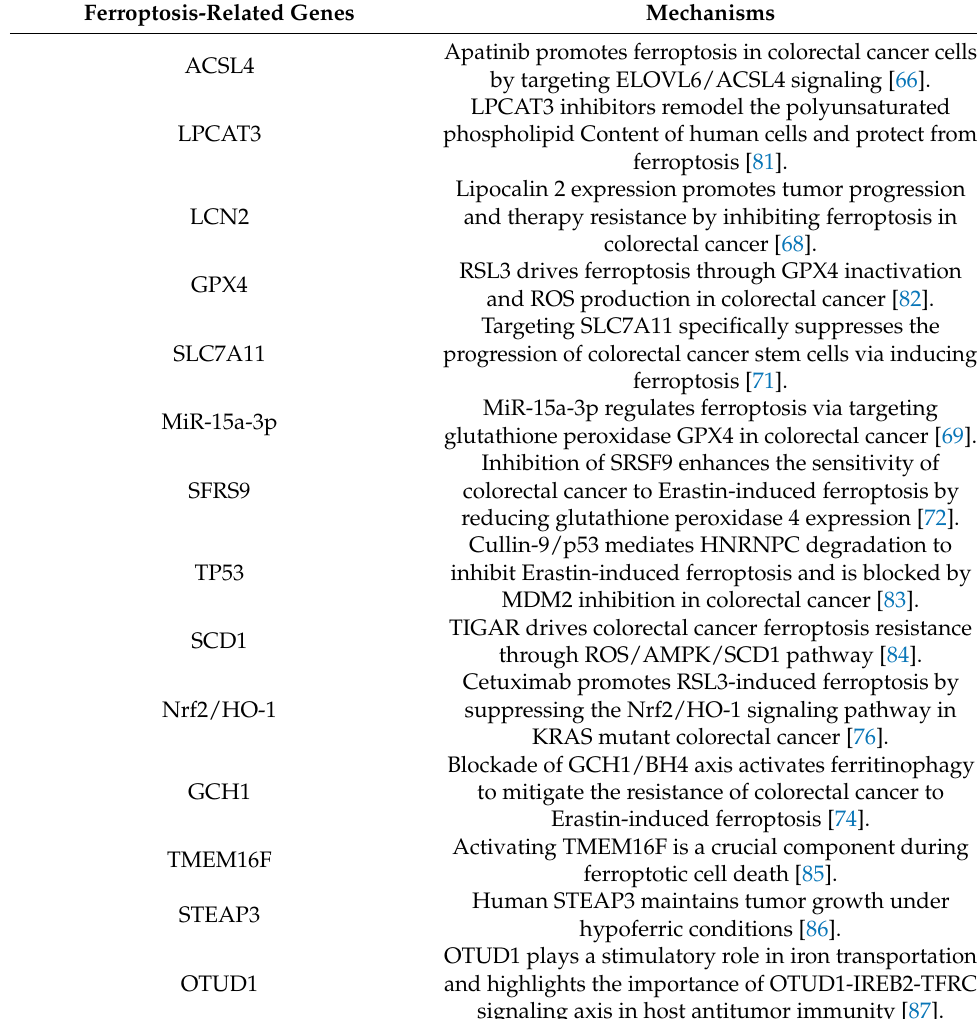
Table 1. Mechanisms of ferroptosis-related genes in